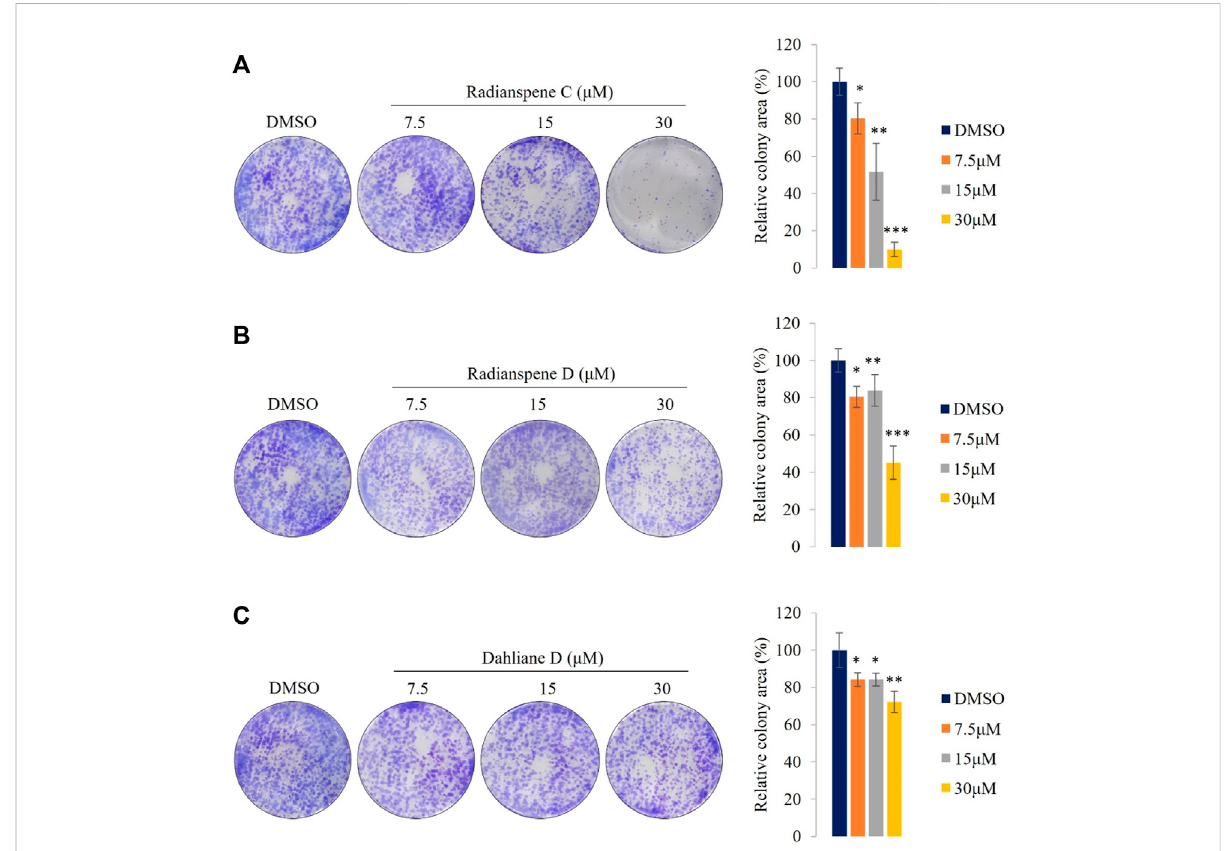
FIGURE 6 Radianspenes C and D, and dahliane D, show anti-proliferative effects against H1975 cells. (A) Radianspene C, (B) radianspene D, and (C) dahliane Dshowanti-proliferative activityinaclonogenicassay.Representative images areshown, alongsidehistogramsshowingthepercentage of colony area in each condition. Data are presented as the mean ± SD, n = 3. * p < 0.05; ** p < 0.01; *** p < 0.001 compared with the DMSO-treated